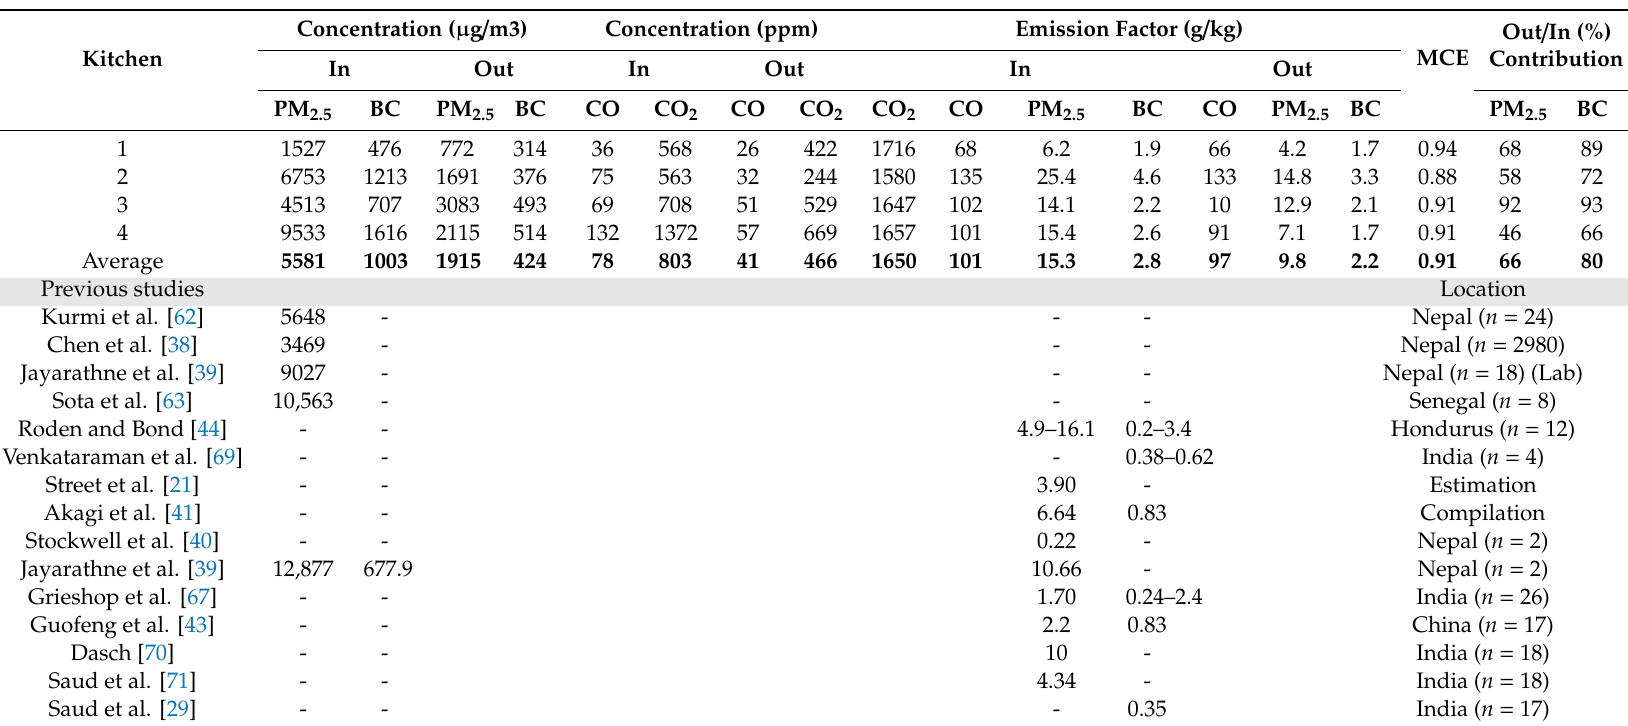
Table 2. Particulate matter of less than 2.5 µ diameter (PM 2.5 ) and black carbon (BC) emission concentration in ( µ g / m 3 ), CO, and CO 2 emission concentration in (ppm) with emission factor (g / kg) and inside to outside contribution in percentage based on emission factor of